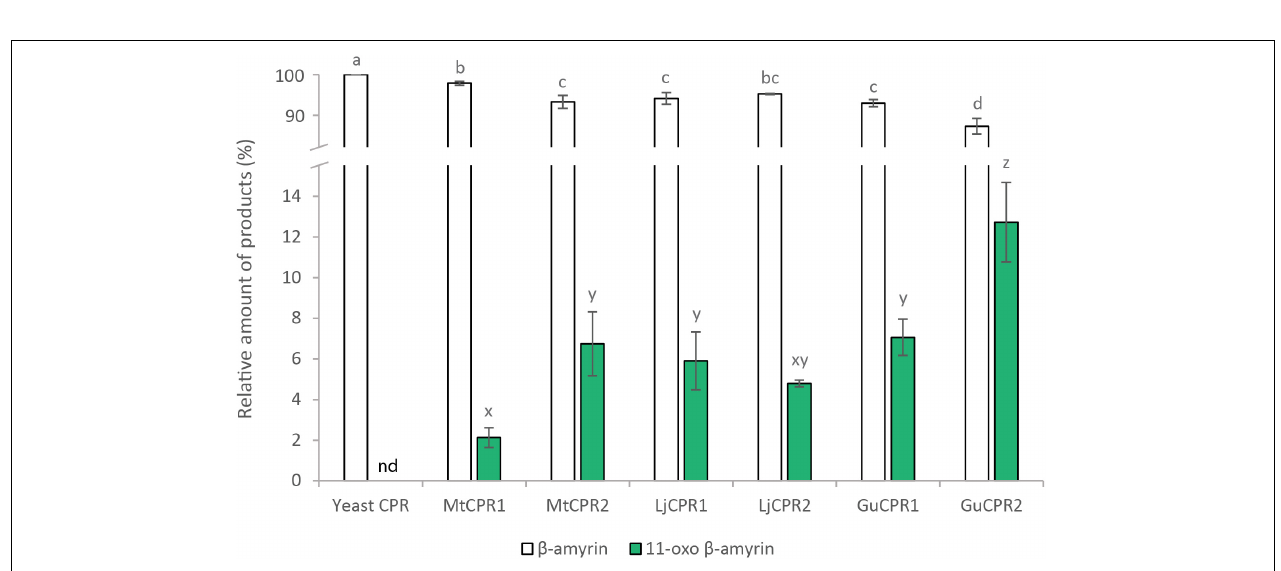
FIGURE 10 | Improving 11-oxo- β -amyrin production using the engineered PSIII yeast strain. The relative amount of triterpenoid in PSIII strain co-expressing different combinations of GuCYP88D6 with different CPRs. 11-oxo- β -amyrin content was measured relative to an internal standard (uvaol). Data have been presented as mean ± SE ( n = 3). nd, signal below detection limit. The different letters indicate significant differences ( P < 0.05, one-way ANOVA followed by Tukey’s test). Letter a–d and x–z are used to indicate significancy for β -amyrin and 11-oxo- β -amyrin content, respectively.